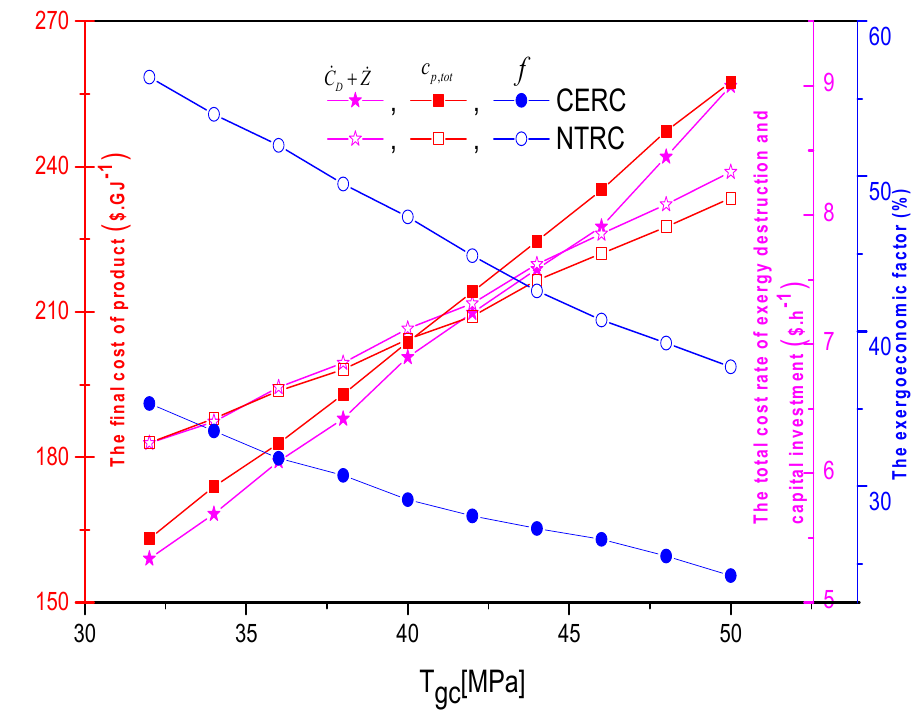
. . Z + C D dependence